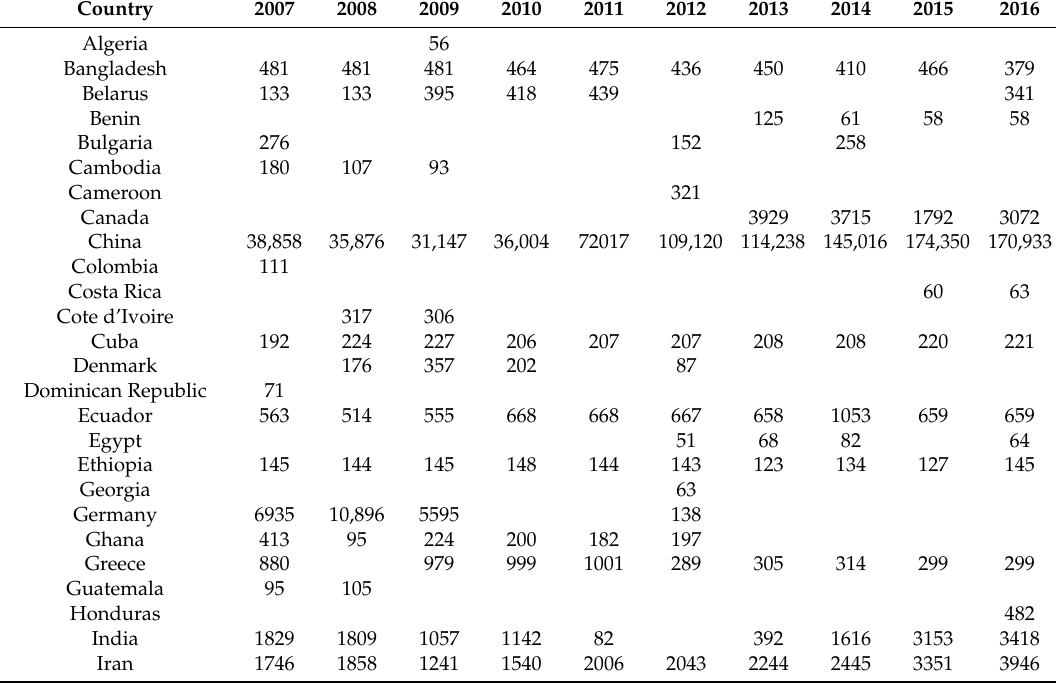
Table 7. Deficit in industrial roundwood supply (harvests + net imports) according to the LP test (1000 m 3 ), if the forest industry production data are correct. Only countries where the deficit is suggested to exceed 50,000 m 3 in any of the years 2007–2016 are listed. Entries less than 50,000 m 3 are not shown.